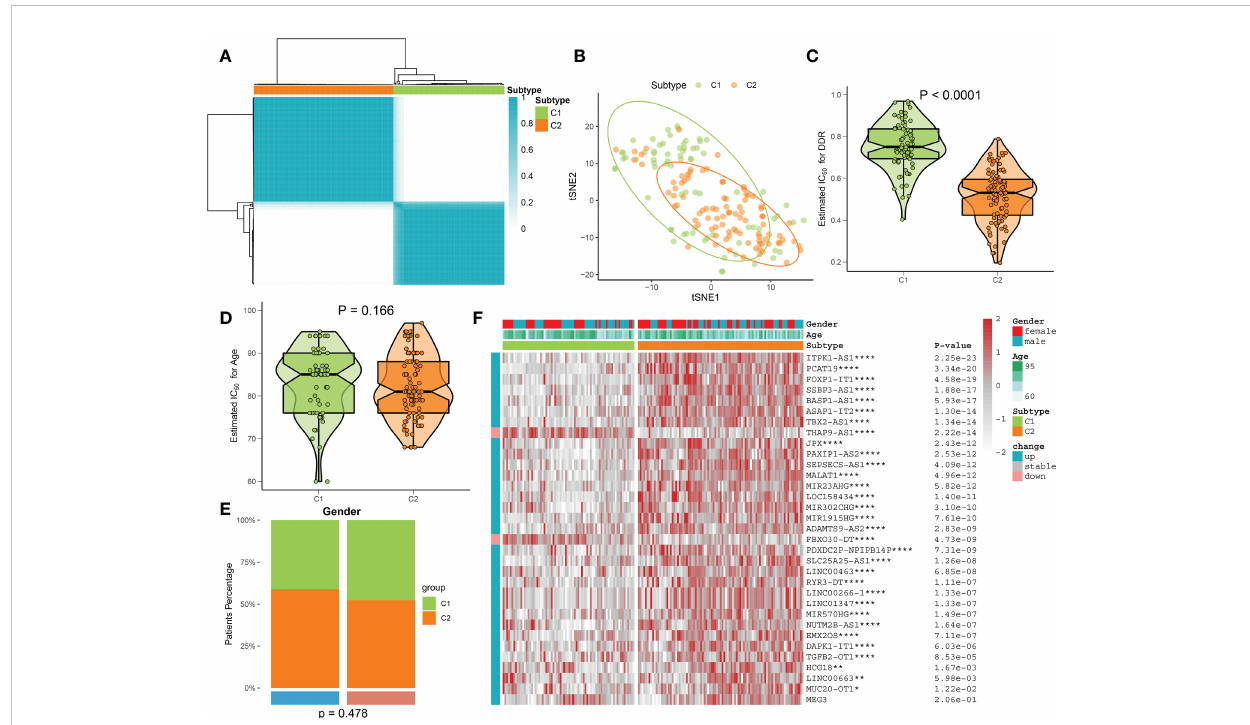
FIGURE 6 Identi fi cationof DDR subtypesusing a consensus clustering algorithm. (A) The consensus clustering matrix of DDR subtypes is depicted based onthe consensus clustering methodology. (B) The DDR C1andC2 samples aredifferentiated using the t-SNE diagram. (C) A comparisonofthe DDR score in